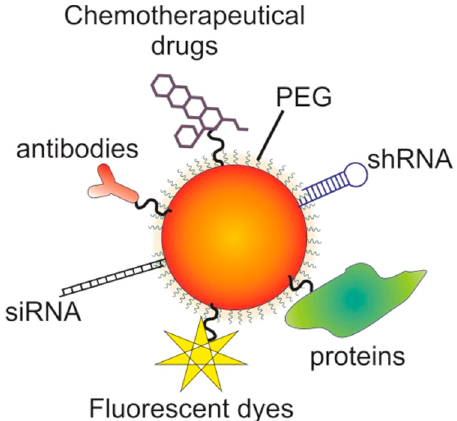
Figure 4. Gold nanoparticles’ (AuNPs) functionalization for theranostics. After functionalization with polyethylene glycol (PEG) for higher biocompatibility, AuNPs may be functionalized with a variety of molecules, including chemotherapeutical drugs, antibodies, small interference RNA (siRNA), short hairpin RNA (shRNA), fluorescent dyes, proteins, or a combination of several biomolecules. Nucleic acid molecules modified with thiol groups at either the 3 ′ or 5 ′ ends show a strong affinity for the AuNP surface, forming quasi-covalent bonds [160]. Using this strategy, it is possible